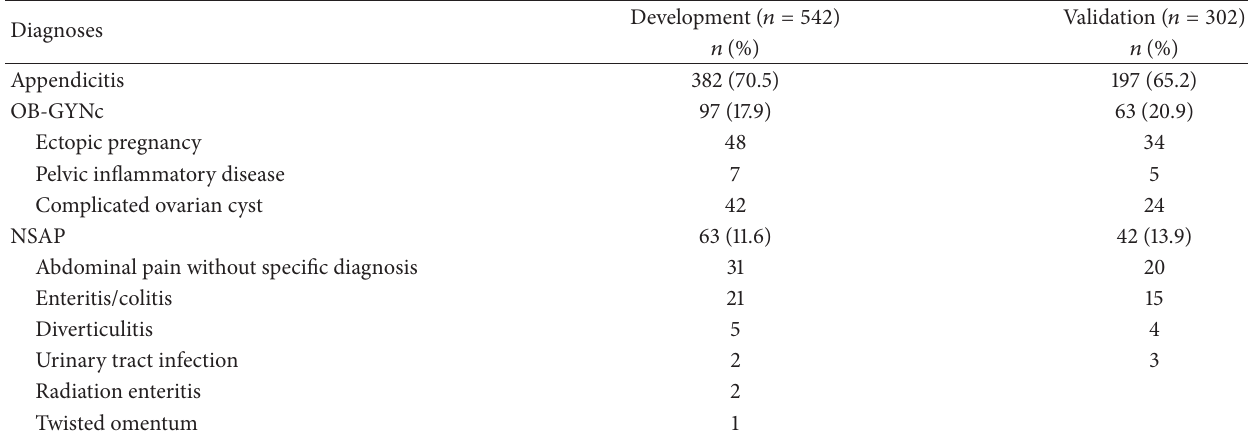
Table 3: Final professional diagnosis of patients in the development data and validation data.